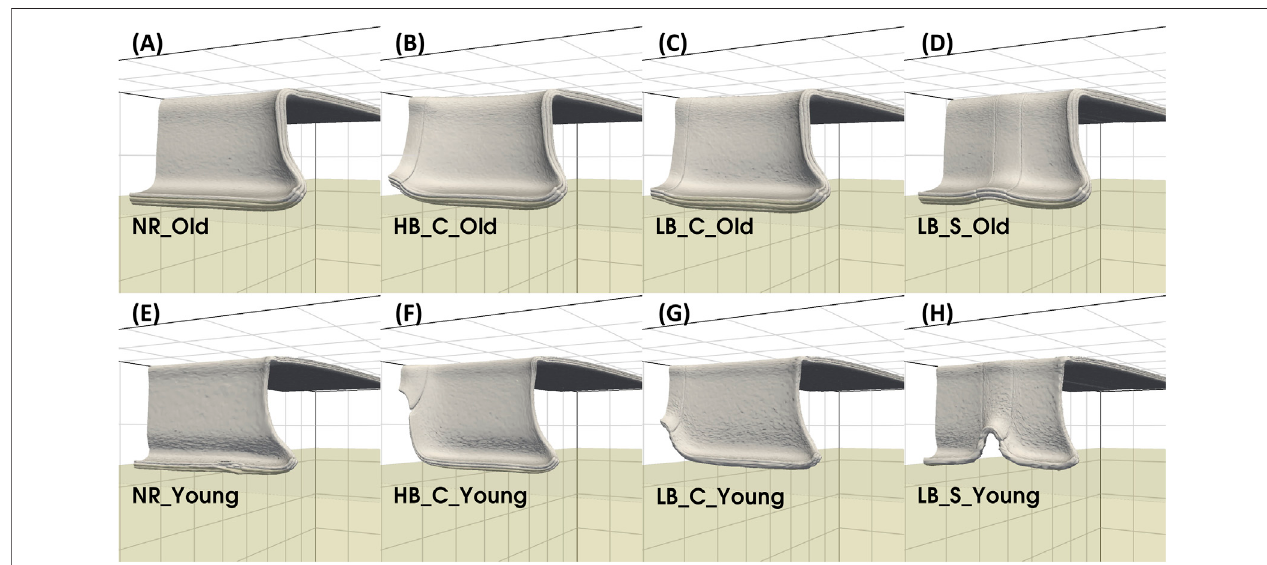
FIGURE2| RepresentativeslabgeometriesafterplatesstartinteractingwiththeULMBforallmodelcases.Oldplatecasesarepresentedinpanels (A – D) at10Myr andyoungplatecasesinpanels (E – H) at30Myr.Thelowermantleisdepictedbygreensemi-transparentbox.Forscale,greygridcellsof400 kmby400 kmareshown on domain boundaries.